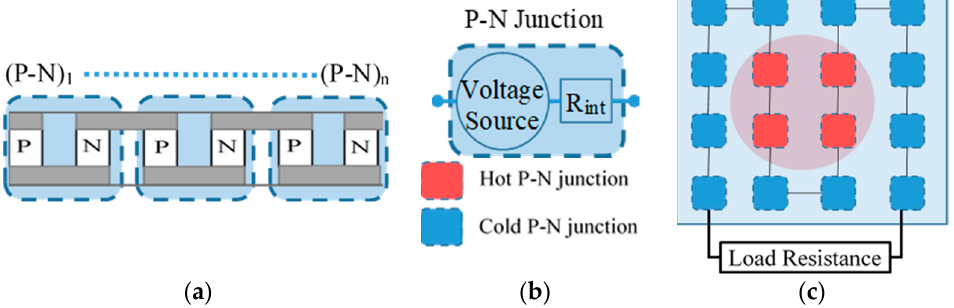
Figure 5. Schematic diagram for ( a ) P-N junctions of a TEG module, ( b ) equivalent circuit of P-N junction, and ( c ) centrally concentrated light on the TEG surface showing hot and cold series-connected P-N junctions.